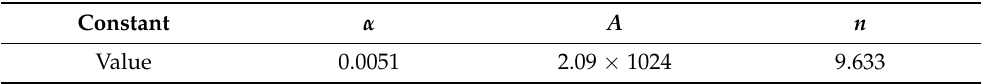
Table 2. Material